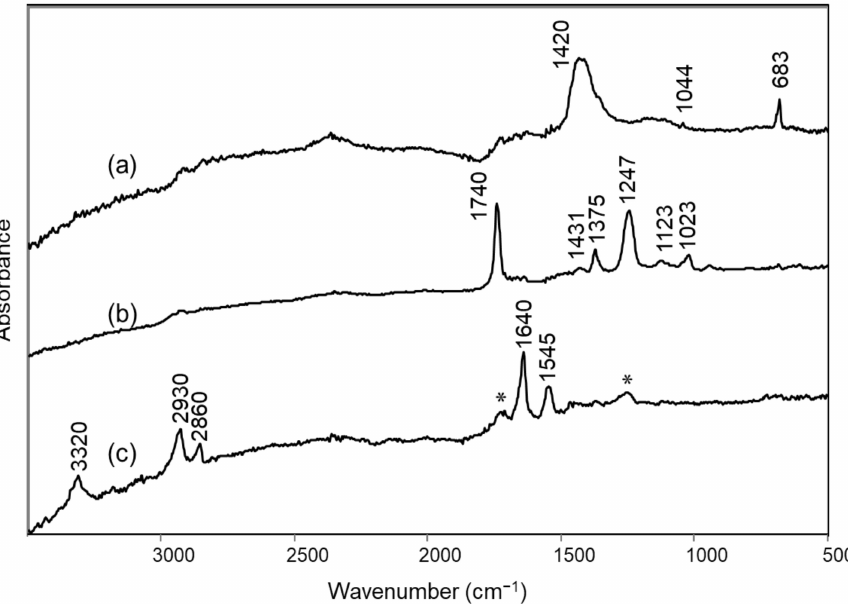
Figure 6. FTIR specular reflection spectra (after Kramers–Kronig transformation) of areas on the back of the “Concetto spaziale”: ( a ) beige canvas (Area 5); ( b ) adhesive residue that gives yellowish fluorescence in UV light (Area 6); ( c ) adhesive residue which gives white fluorescence in UV light (Area 7). In spectrum ( c ), the bands marked with an asterisk (*) are probably due to residues of the PVA